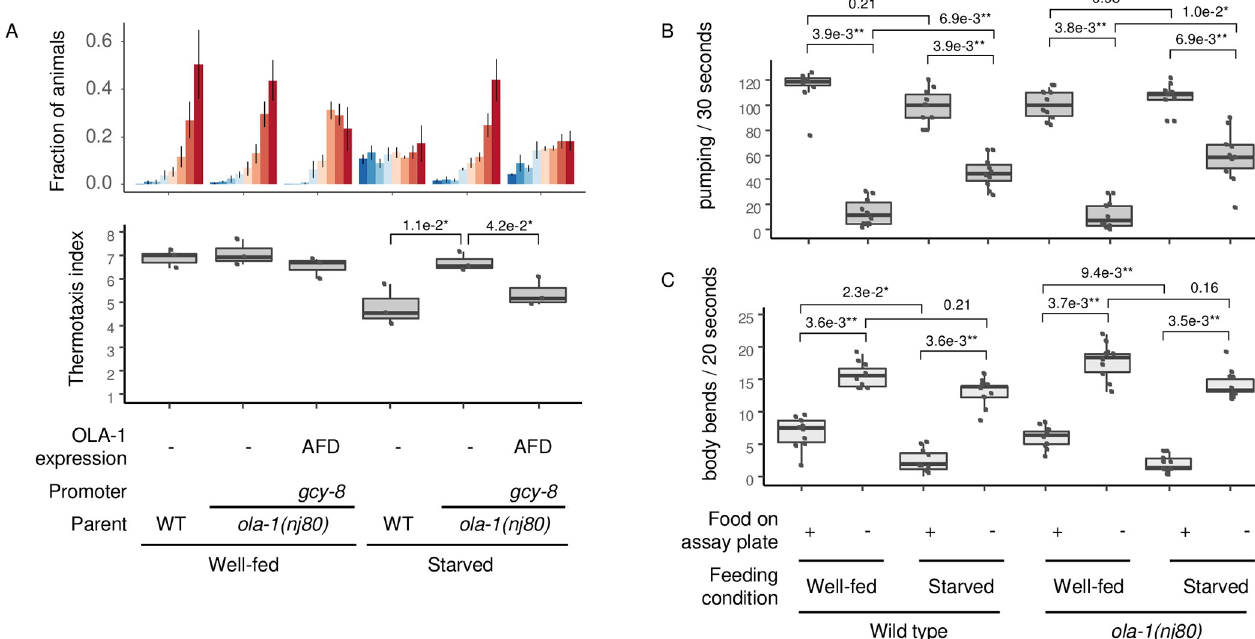
Fig 5. ola-1 does not modify thermotaxis behavior after starvation. (A) Wild type and ola-1(nj80) animals were cultivated at 23˚C, transferred to NGM plates with (well-fed) or without (starved) food and cultivated at 23˚C for 2 h. Animals were then allowed to freely migrate on a thermal gradient for 1 h. n = 3. p values are indicated (one-tailed Dunnett test against starved ola-1(nj80) animals). (B-C) Well-fed and starved animals of wild type and ola-1(nj80) were transferred to new NGM plates with or without bacterial food and recorded. Pharyngeal pumping (B) or body bending (C) were visually counted. n = 10. p values were indicated (Steel-Dwass